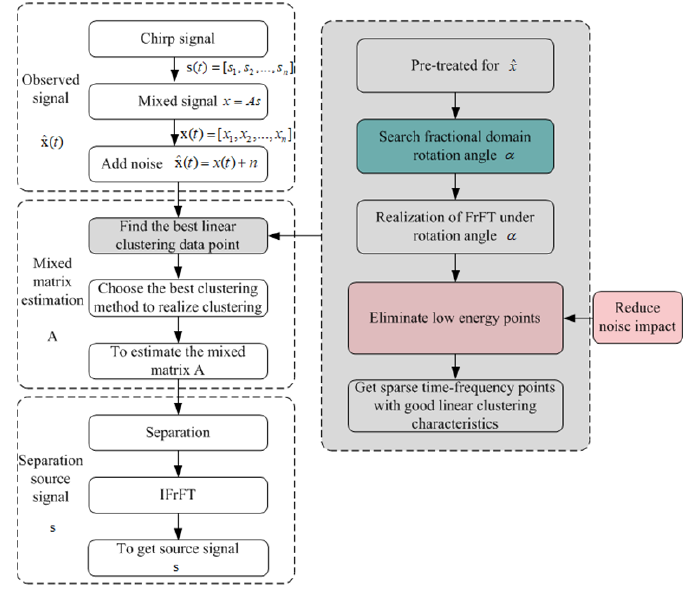
Figure 1. Flow chart of α -UBSS algorithm proposed in this paper.